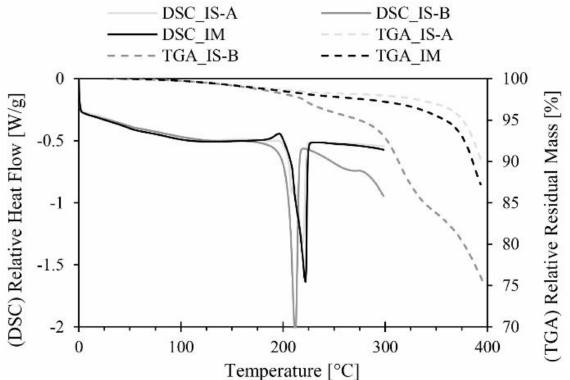
Figure 8. Differential scanning calorimetry (DSC) and thermogravimetric analysis (TGA) curves for the three different